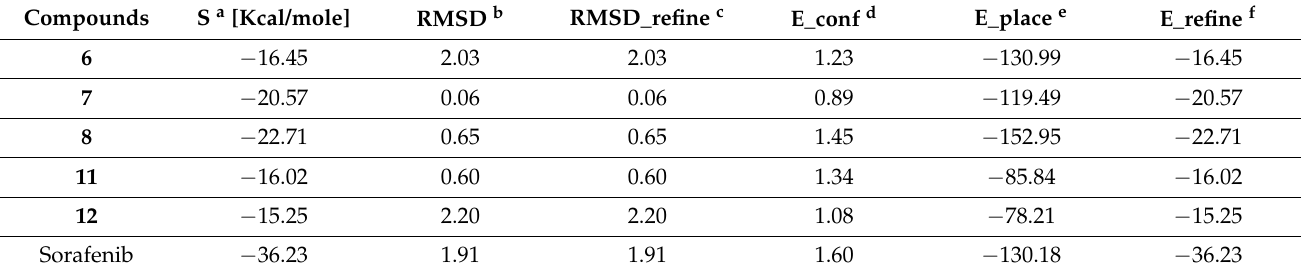
Figure 5. ( A ) the superimposition of the re-docked conformer (green) of sorafenib over the co-crystallized (original) one (pink) with an RMSD value of 0.79 Å. ( B ) the superimposition of the re-docked conformer (green) of sorafenib over the co-crystallized (original) one (pink) showing the essential binding against the active site. Table 7. The calculated S scores (binding free energies) of the examined compounds and sorafenib against VEGFR-2 (∆G in Kcal/mole).